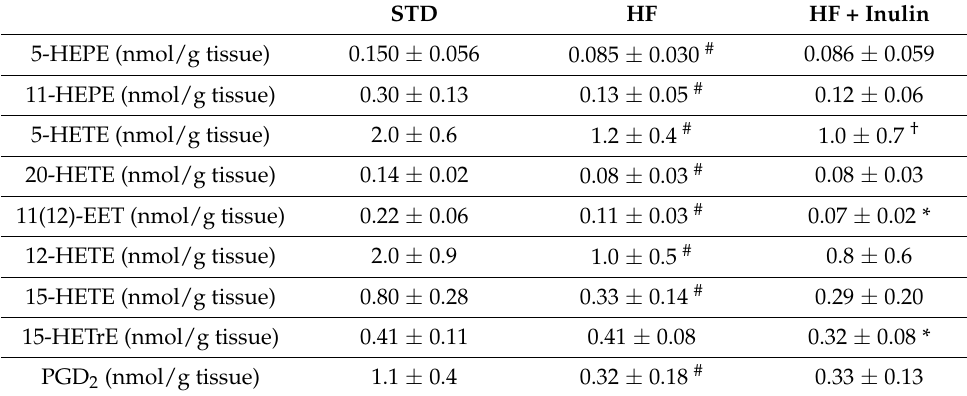
Table 2. Non-esterified eicosanoids in liver at the end of the